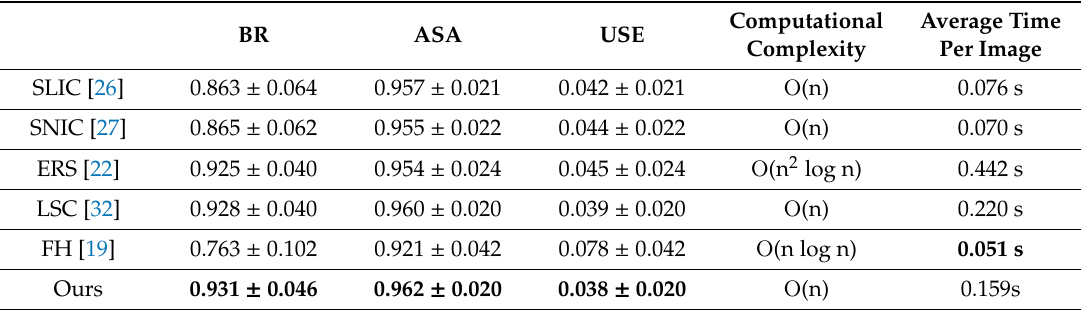
Figure 8. Quantitative evaluation of di ff erent superpixel segmentation algorithms. Table 2. Performance metrics of di ff erent superpixel segmentation algorithms at k =